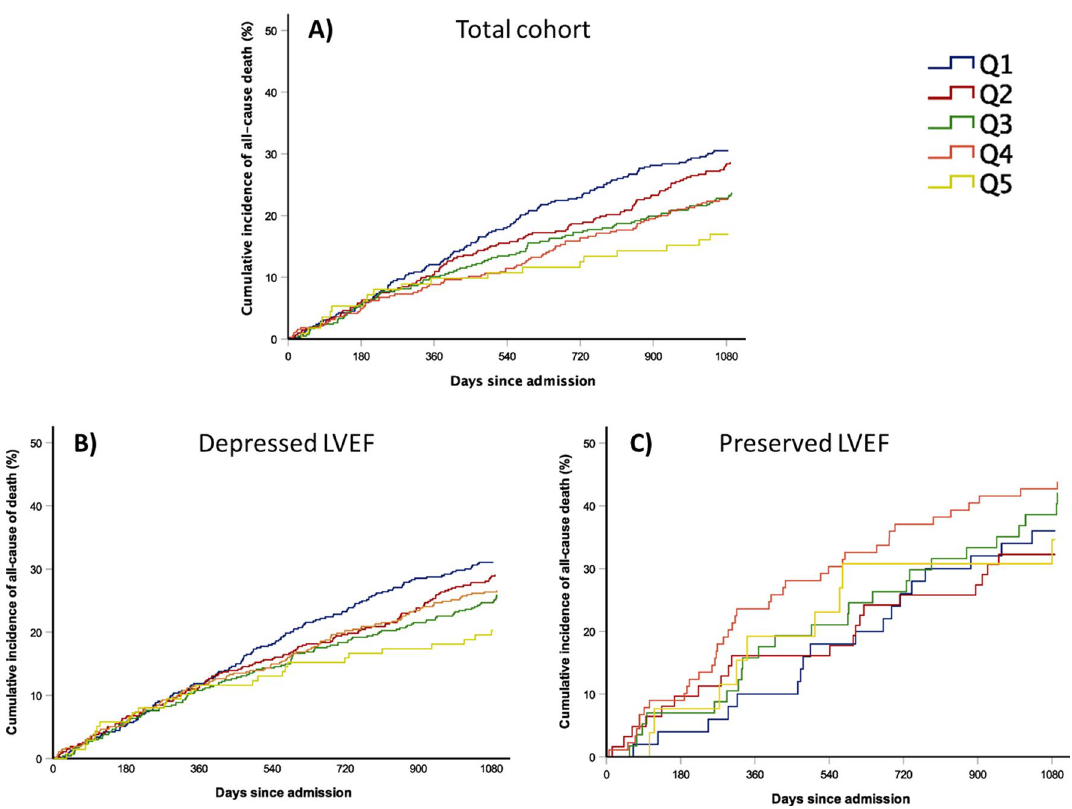
Figure 1. Cumulative incidence of death based on quintiles of period of admission; ( A ) Total cohort population; ( B ) Patients with depressed LVEF; ( C ) Patients with preserved LVEF. Q1, quintile 1, August 2001-August 2004; Q2, quintile 2, September 2004-November 2008; Q3, quintile 3, November 2008-June 2012; Q4, quintile 4, June 2012-October 2015; Q5, quintile 5, October 2015-September